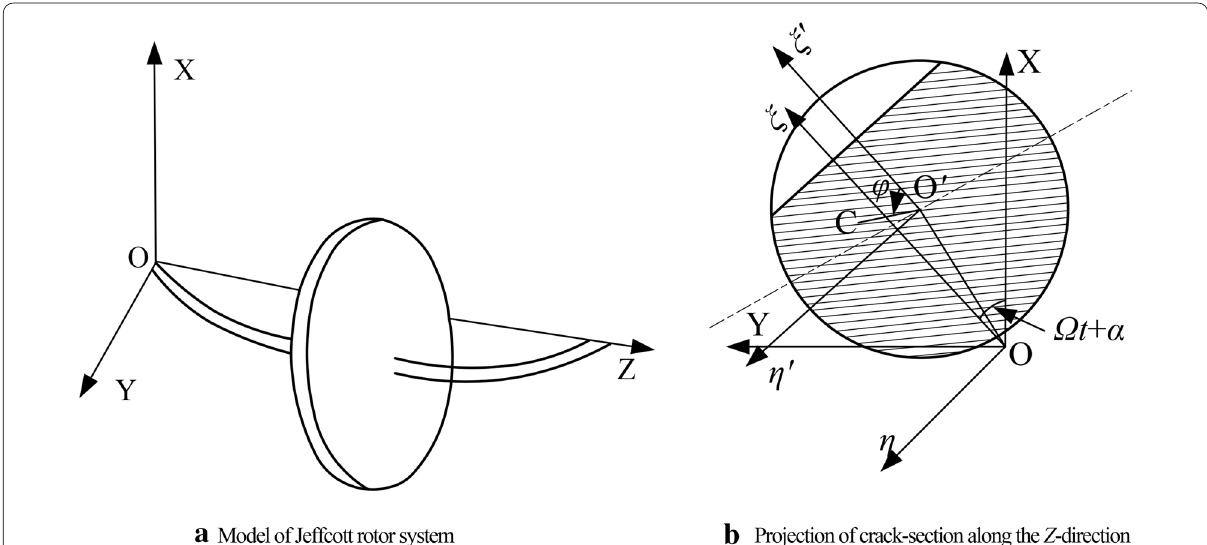
Figure 4 The Jeffcott rotor system with a slant crack of 45° and the projection of crack-section in the Z -direction